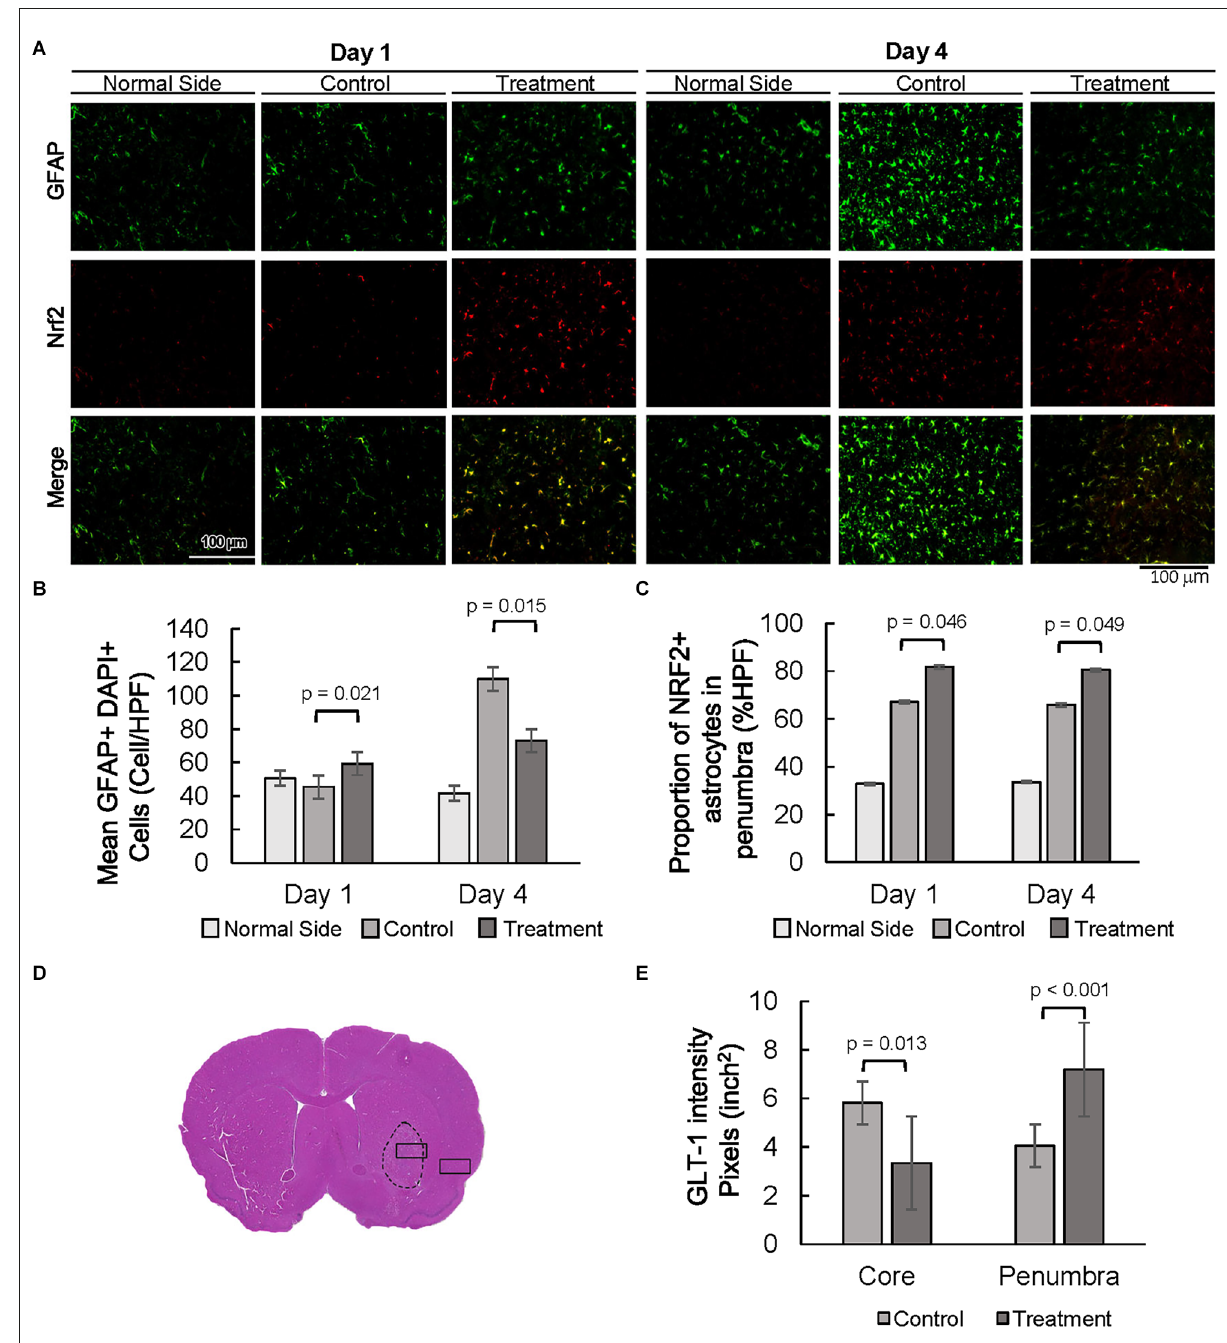
FIGURE4 Decreased astrogliosis is associated with an increased proportion of NRF2 and GLT-1 positive astrocytes. (A) Representative images of GFAP and NRF2 in the contralateral side (normal side) and penumbra 1 day and 4 days post-MCAO R. (B) Number of astrocytes in the penumbra. (C) The proportion of GFAP positive, NRF2 positive astrocytes in the penumbra. (D) Representative H&E section with area of sampling in core (box inside dashed area) and penumbra (box outside dashed area). (E) Quantification of the intensity of GLT-1 staining in the core and penumbra as shown in Supplementary Figure 2 . Day 1 and day 4 n = 10 control, 10 drug-treated, three HPF per